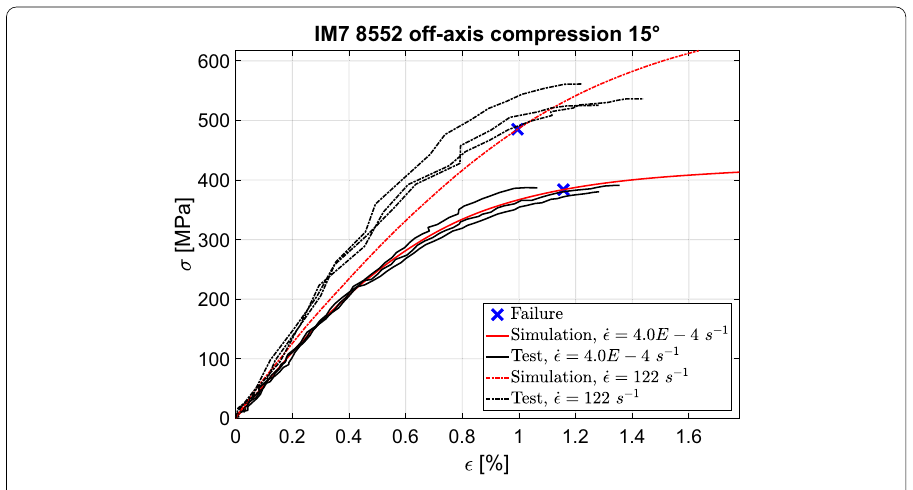
Fig. 16 True stress–true strain curves for the compression tests and simulations, 15 ◦